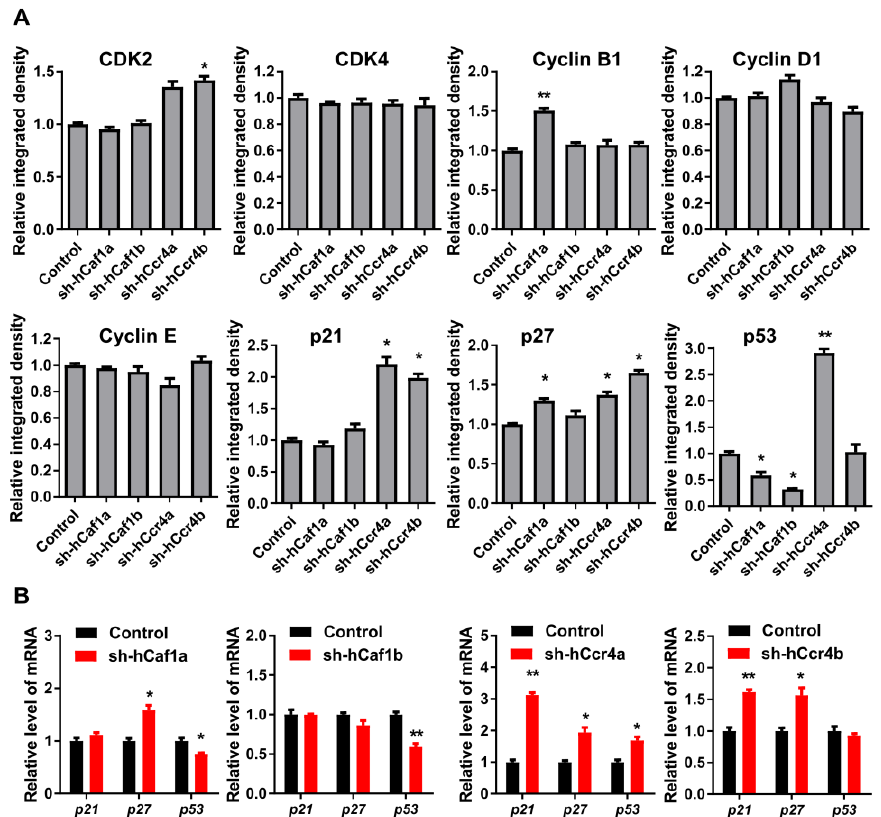
Figure 4. Effects of hCcr4a/b- or hCaf1a/b-knockdown on the expression of key cell cycle regulators in the MKN28 cells. ( A ) Protein levels of the cell cycle regulators determined by Western blot ( n = 3); ( B ) The steady-state mRNA levels of p21 , p27, and p53 ( n = 3). * p < 0.05, ** p < 0.01, and *** p < 0.001.